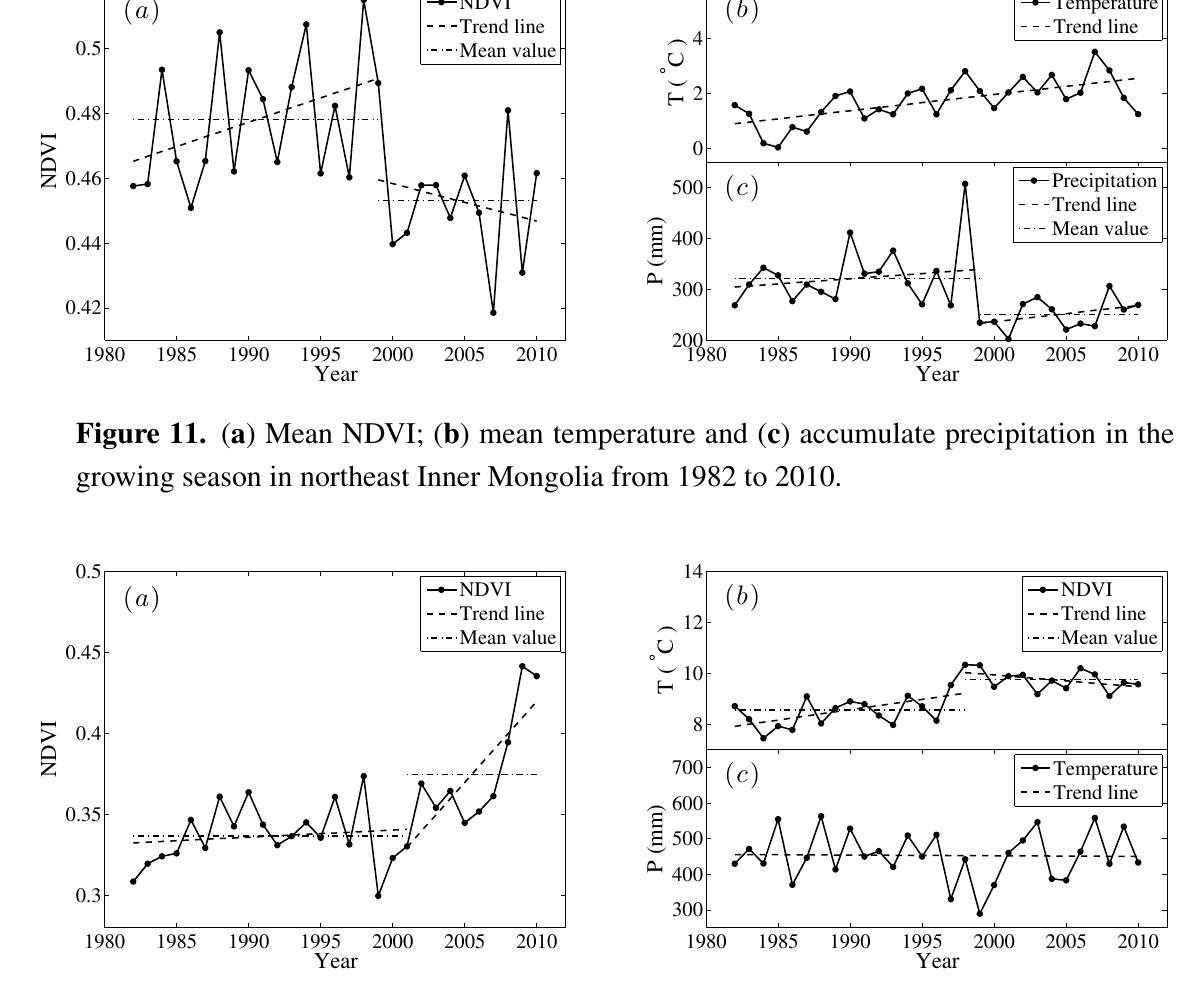
Figure 12. ( a ) Mean NDVI; ( b ) mean temperature and ( c ) accumulate precipitation in the growing season in Loess Plateau from 1982 to